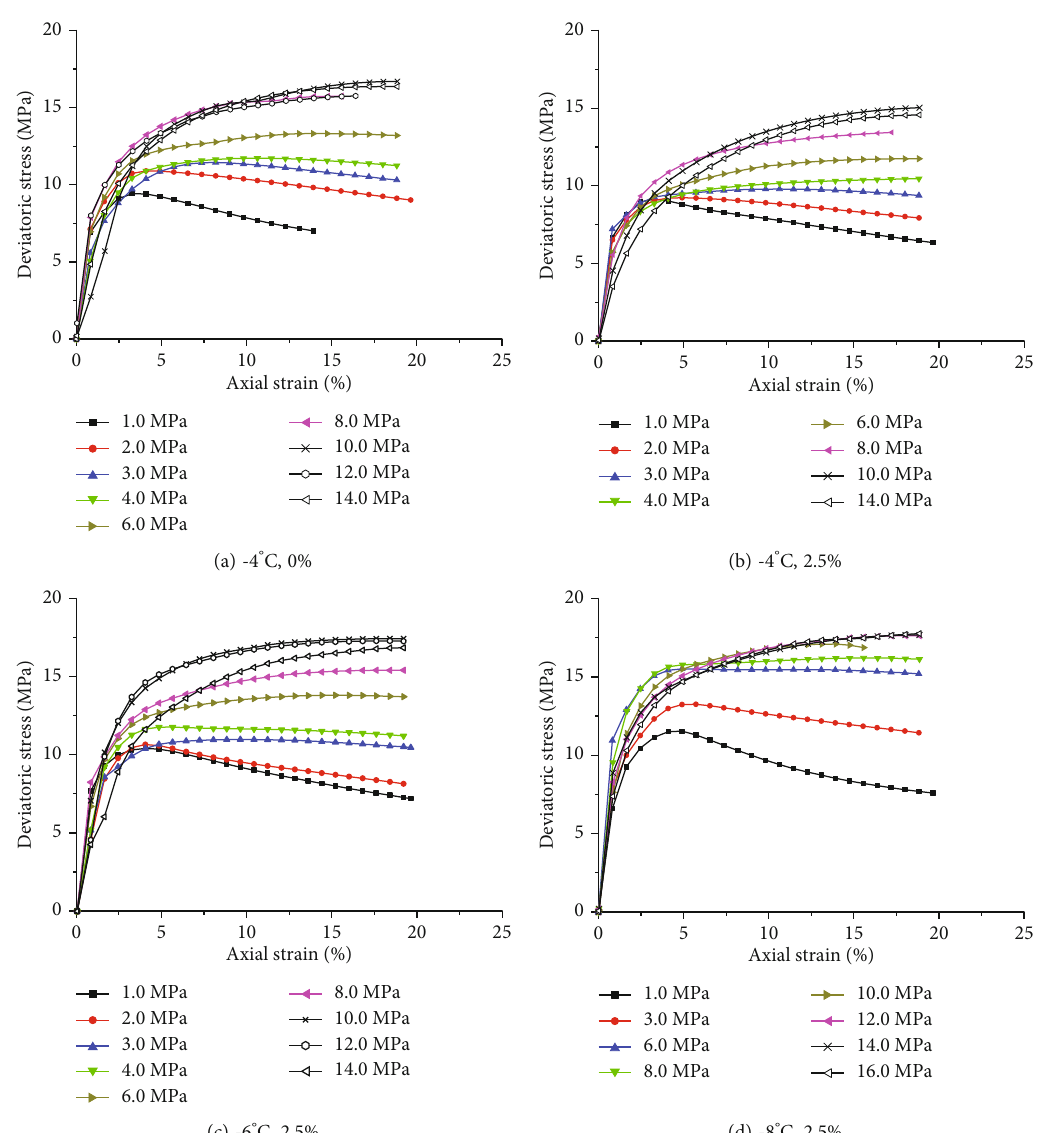
Figure 1: Stress-strain curves for frozen saline sandy samples at various